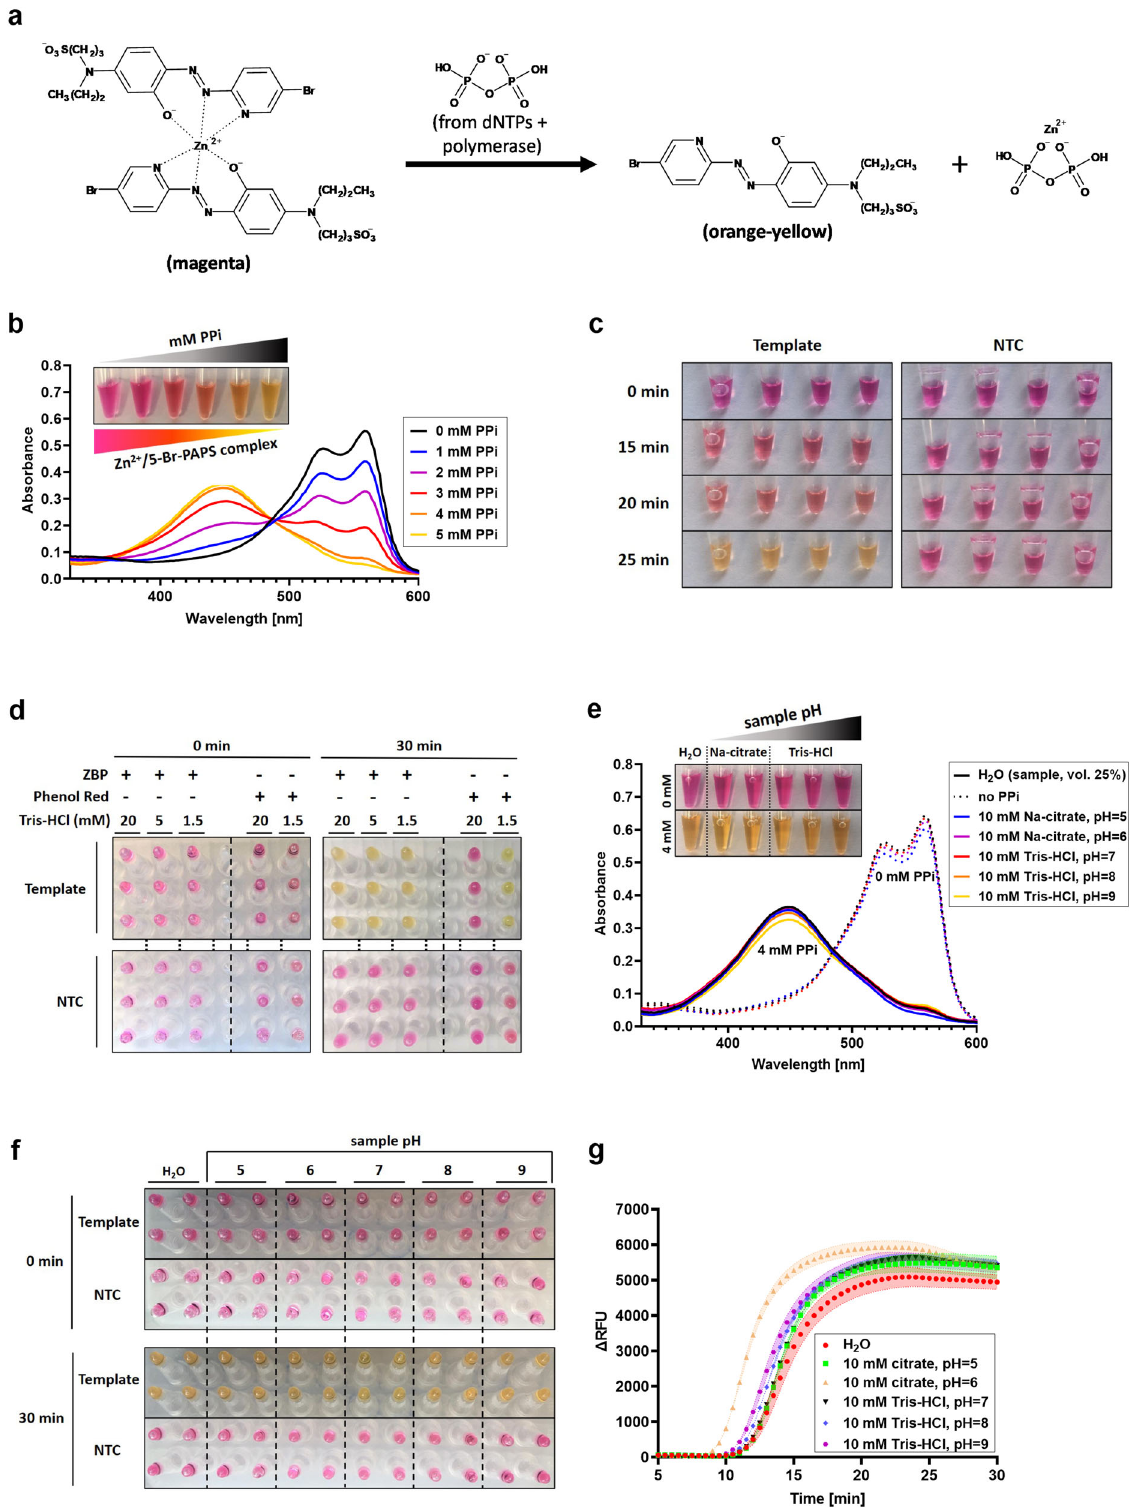
Instead of using HNB or related compounds, we designed a colorimetric metallochromic dye-based detection system. We introduced a low micromolar concentration of a new ion into the reaction mix, Zn 2 + , along with a highly speci fi c Zn 2 + metallochromic indicator, 5-Br-PAPS. Zn 2 + forms extremely stable and insoluble complexes with pyrophosphate, a feature exploited in the gravimetric detection of zinc 72 , while